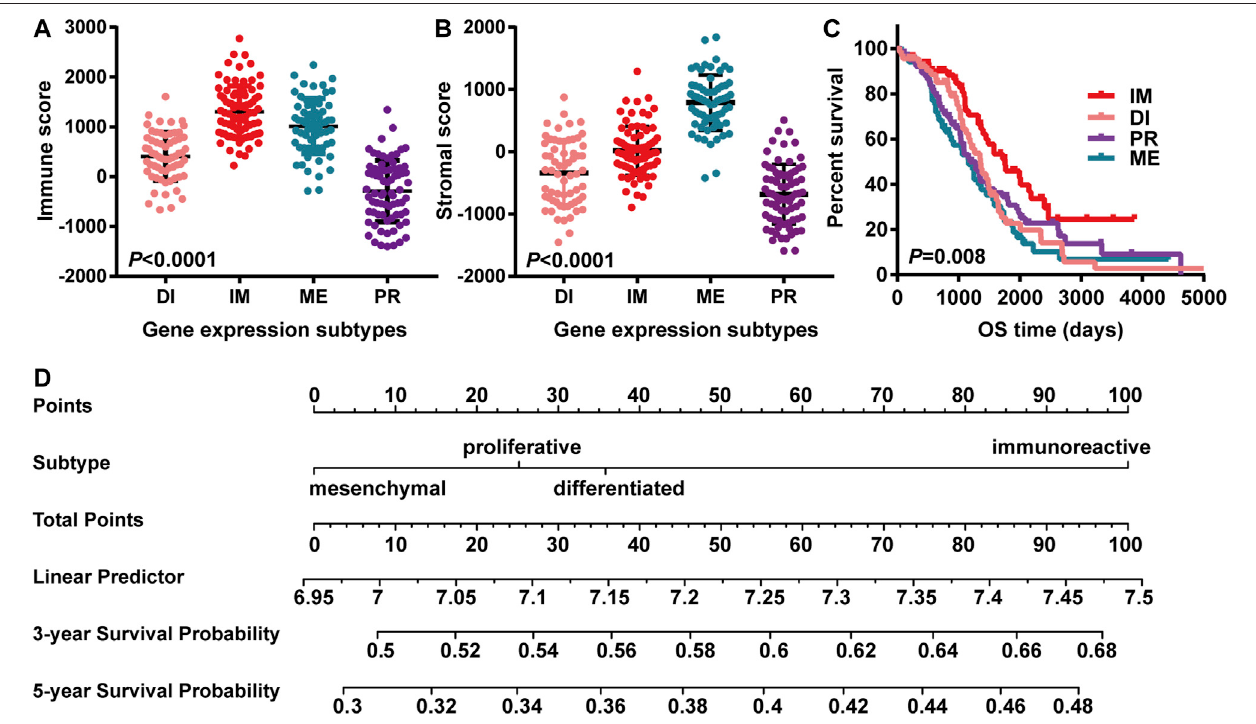
FIGURE 1 | OV gene expression subtypes were signi fi cantly associated with immune score and overall survival. “ IM ” “ PR ” “ ME ” “ DI ” indicated “ immunoreactive type ” “ proliferative type ” “ mesenchymal type ” and “ differentiation type, ” respectively. (A) Distribution of immune scores; OV subtypes had signi fi cant correlations with immunescores;represented bythehistogram( n (cid:1) 308, p -value < 0.05); (B) Distribution ofstromalscores;OVsubtypeshad signi fi cantcorrelationswithstromalscores; represented by the histogram ( n (cid:1) 308, p -value < 0.05); (C) The survival relationship between the immunoreactive group and the other groups. Kaplan Meier ’ s survival curve showed that the prognosis of the immunoreactive group was better than that of the other groups, as demonstrated by log-rank, p -value < 0.05. (D) The nomogram showed the 3 years and 5 years survival probability among different subgroups. The immunoreactive subgroup scored higher than the rest ones.